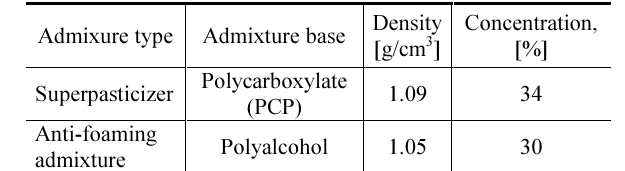
Table 7. Characteristics of